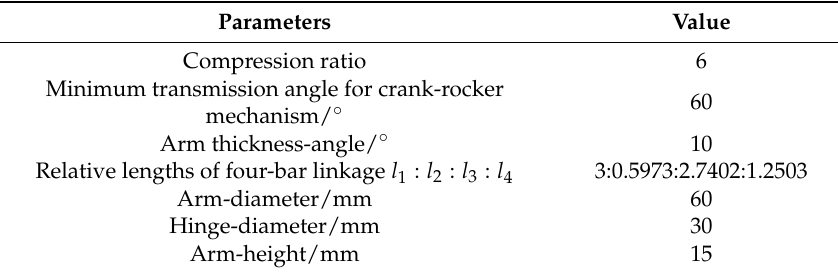
Figure 5. Included angle between two arms. 3. Thermodynamic Characteristics of the Micro Swing Rotor Engine 3.1. Thermodynamic Model for the MSRE in Steady Operation State and the Solution Method Without regard for the details of the physical-chemical process in combustion and the inhomogeneous distribution of the working medium in space field [39,40], the single-dimensional combustion model was adopted to research the thermodynamic characteristics of the MSRE. Based on the fundamental thermodynamic processes in each chamber, differential equations are given to present the working processes for each stroke, and the time-variation process of each thermodynamic parameter is numerically solved. 3.1.1. Establishment of the Thermodynamic Model When the engine operated stably, the four chambers were in four distinct stroke processes in order at any moment. In combination with conservation equations, the gas equation of state, and the Wiebe function for heat release in combustion, the uniform single-dimensional thermodynamic governing model for each chamber at any stroke was established [31], in which the chamber was treated as an open thermal system. Accordingly, the temperature derivative T  , the pressure derivative p  , and the mass derivative m  for the control volume are expressed as: